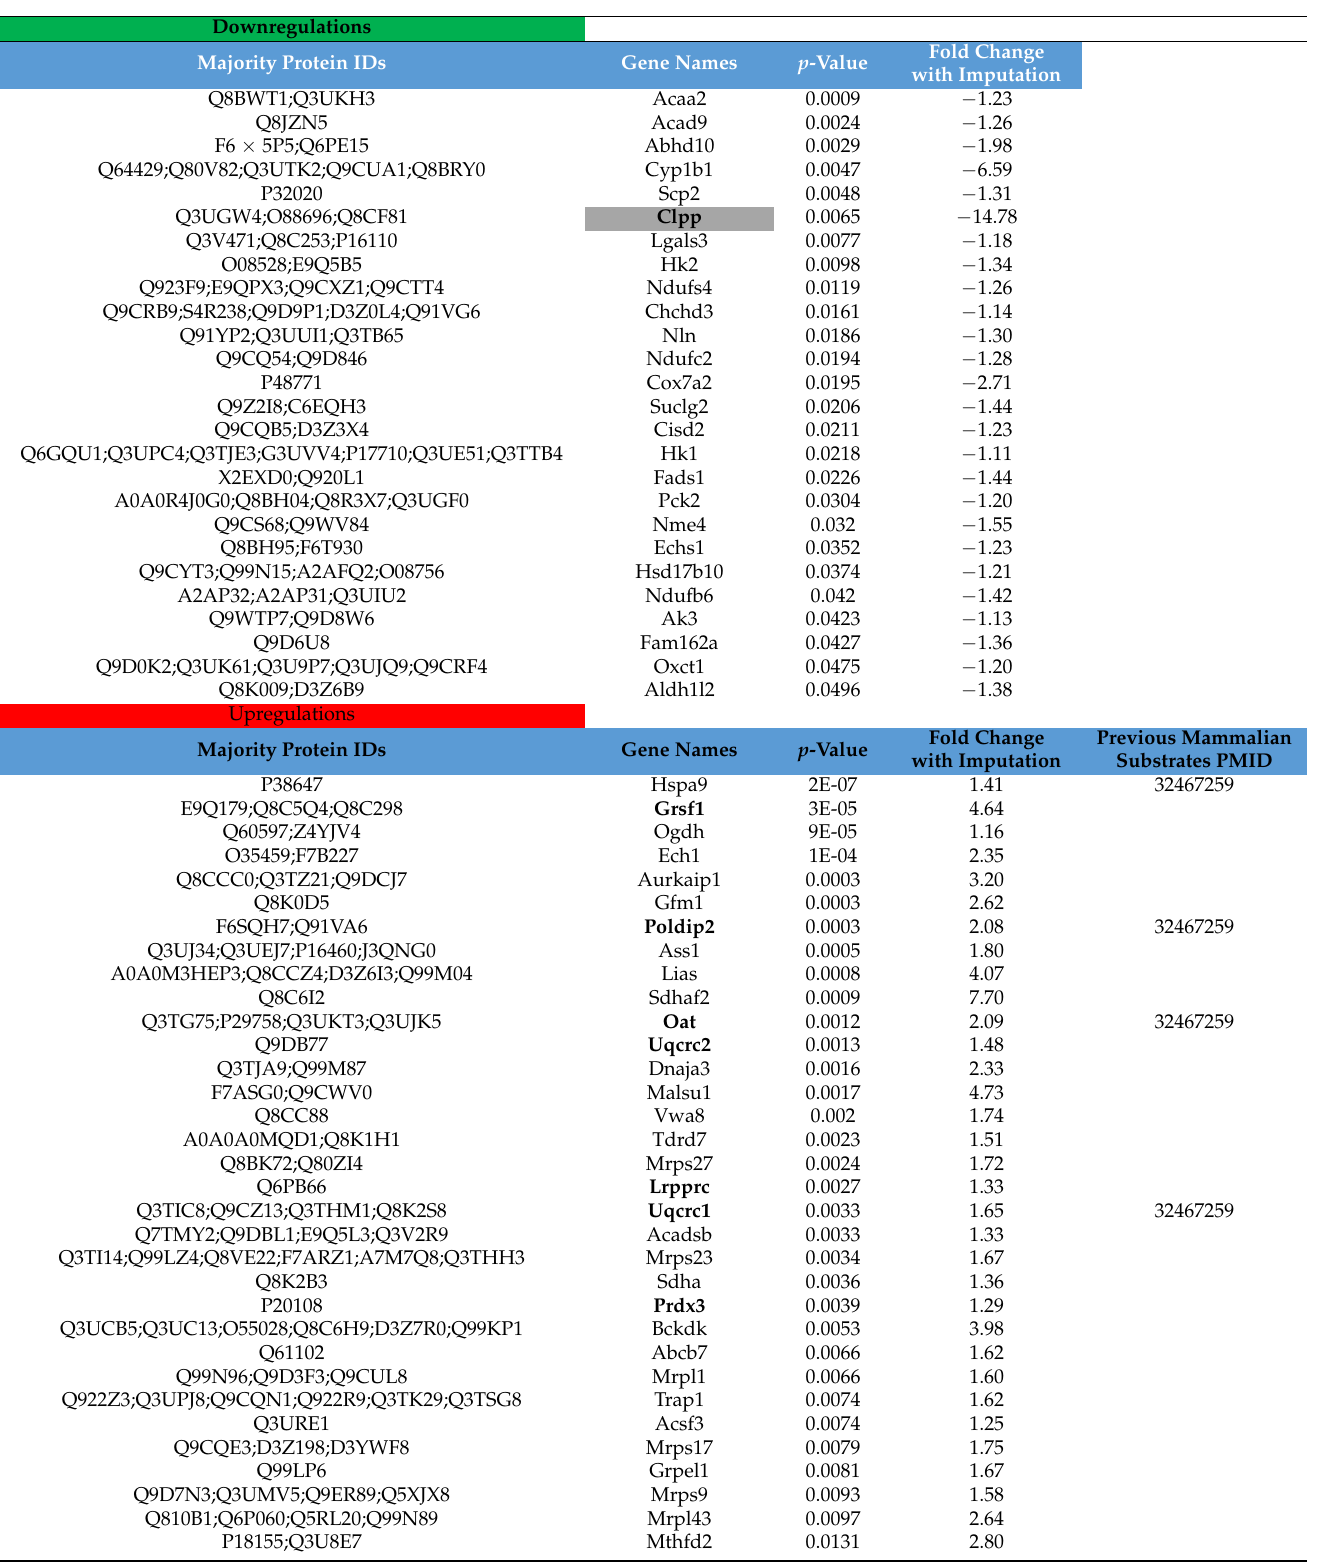
Table 1. Mitochondrial proteins (UniProt-IDs) with significant downregulation (upper part) and upregulation (lower part) in ClpP-null MEFs versus WT (3 versus 3). Factors with special relevance for this manuscript are highlighted in bold letters. Previously reported candidate ClpP cleavage substrates in mouse are identified at the right margin with citations of the relevant PubMed-ID